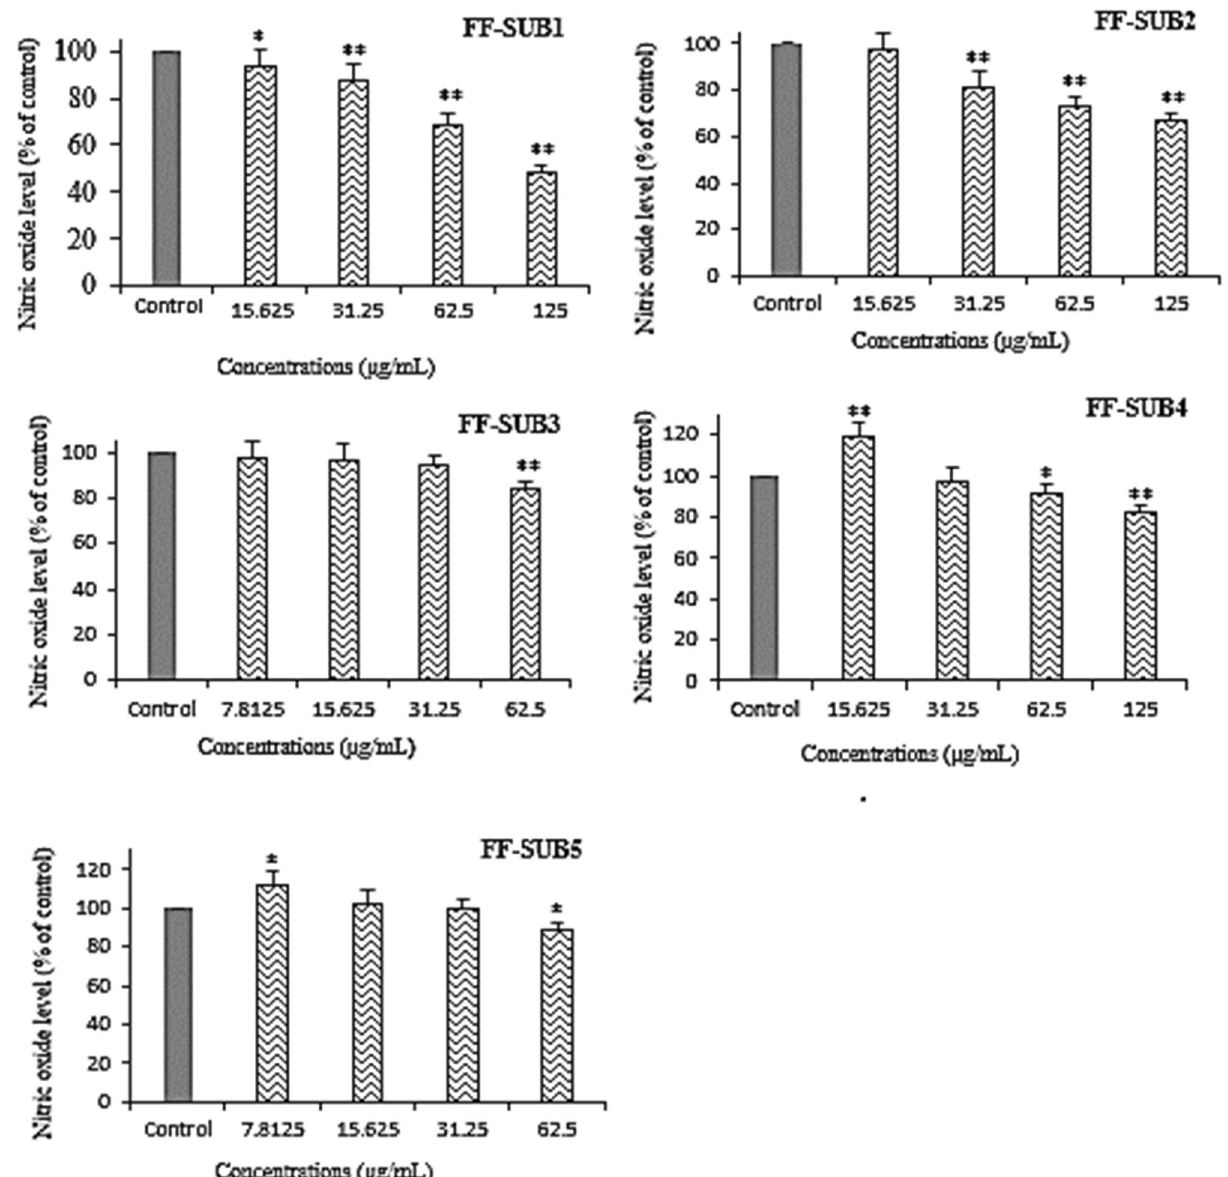
Figure 5. Effects of five subfractions of Fr. F, namely FF-SUB 1 to FF-SUB 5 , on nitric oxide production by RAW 264.7 cells after treatment with LPS. All bars and values represent the mean ± SD of at least three replicate experiments. *Significant difference (P < 0.05) and **P < 0.01 when compared to the control